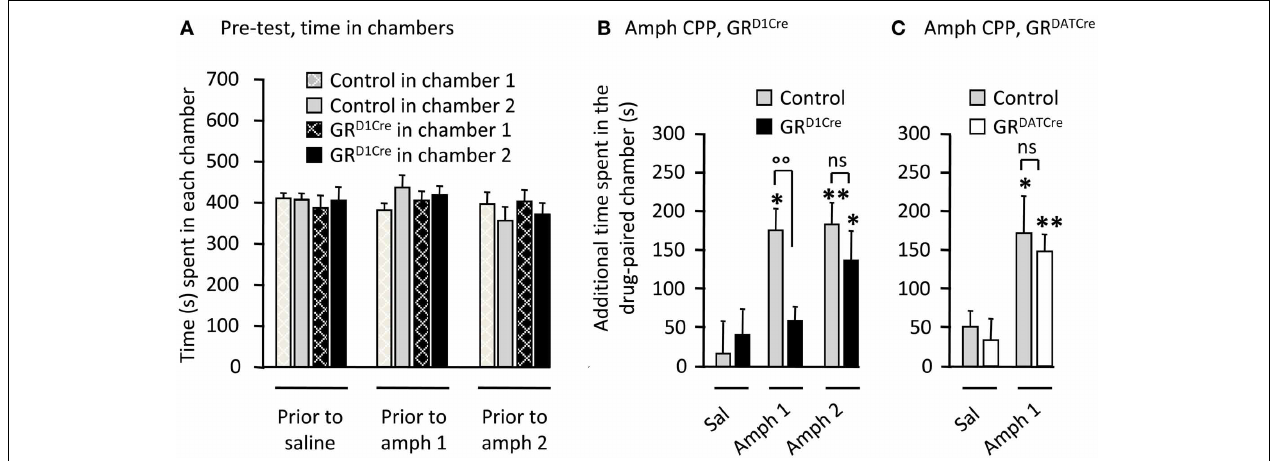
FIGURE 3 | GR D1Cre mice show a decreased sensitivity to amphetamine rewarding properties. CPP scores represent the time difference between post-conditioning and pre-conditioning phases that mice spent in the reward-paired chamber. (A) Time spent in each chamber of the CPP apparatus by control (gray bars) and GR D1Cre mice (black bars), during the pre-conditioning phase. (B) CPP to amphetamine 1 and 2mg/kg in control